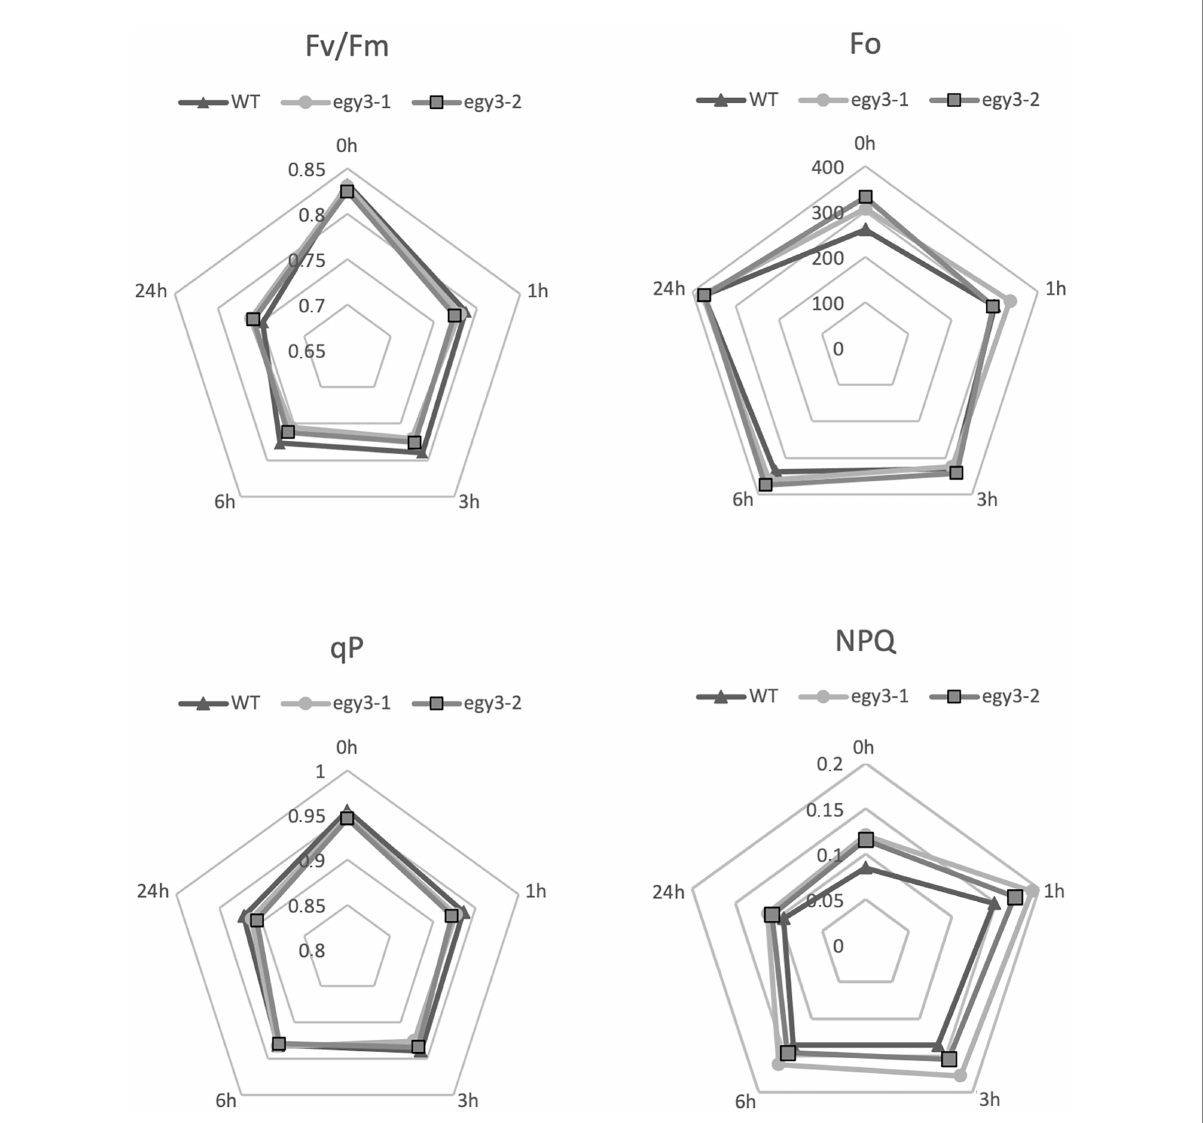
FIGURE 11 Comparison of chlorophyll fluorescence parameters in wild-type (WT) plants and egy3 mutants during exposition to high light stress. The presented values are average from three biological replicates (10 plants each).